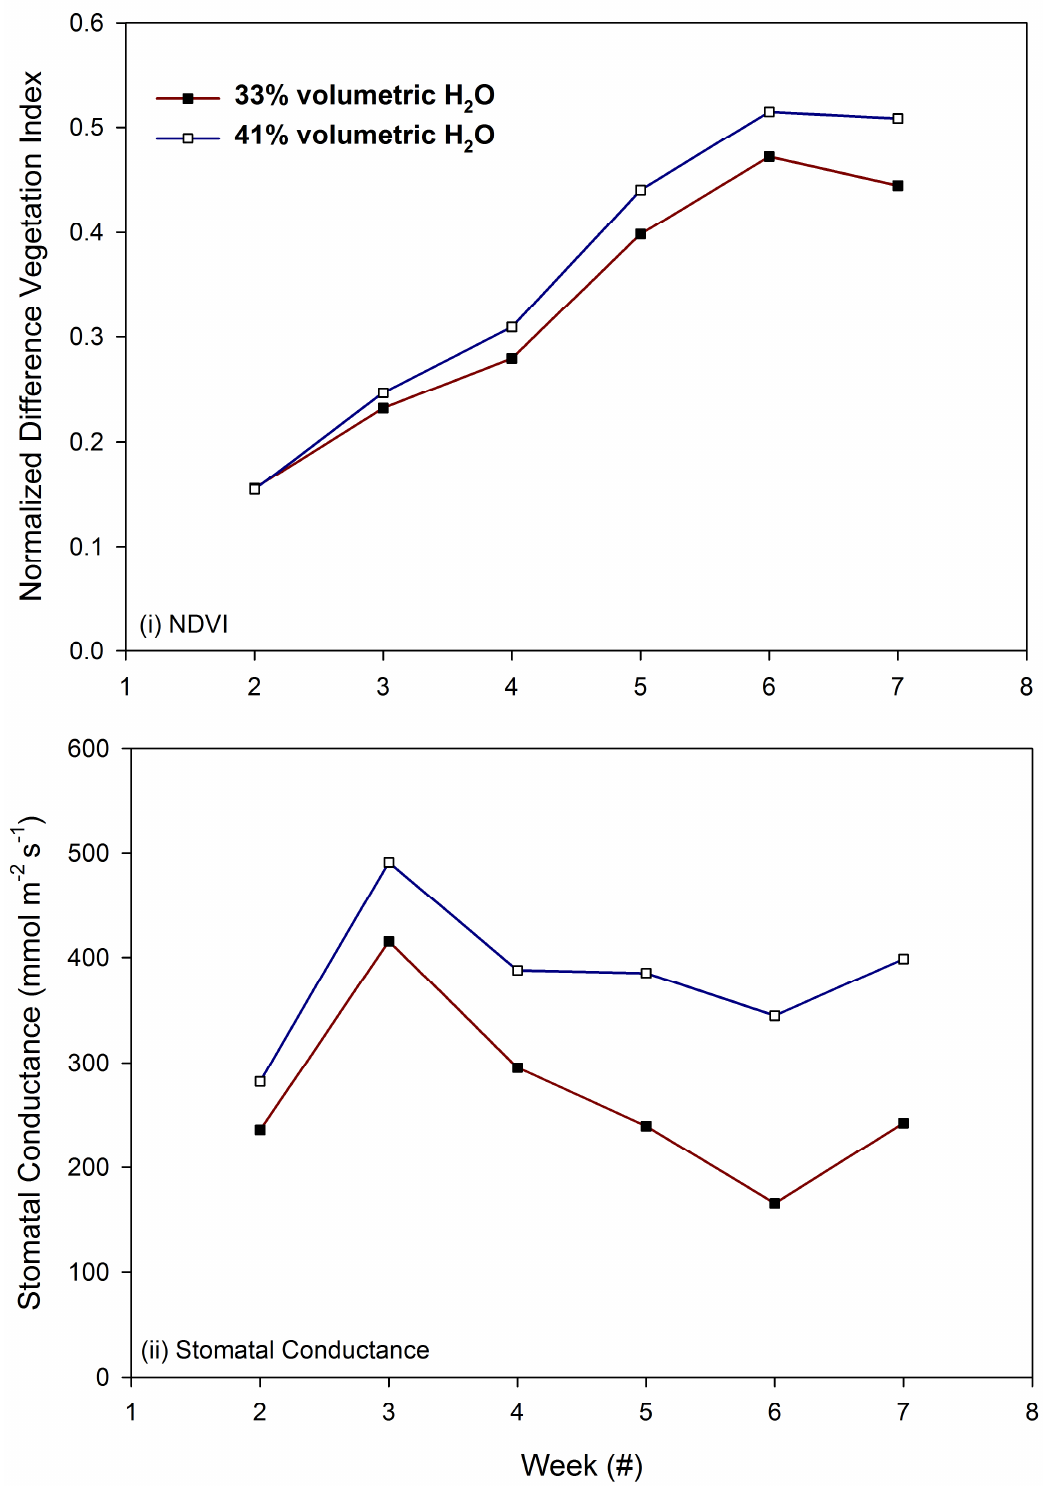
Figure 4. Temporal changes of ( i ) normalized difference vegetation index (NDVI) and ( ii ) stomatal conductance (g s ) per water content treatments. The changes on a weekly basis of the NDVI and stomatal conductance measurements for mean values of each treatment combination are shown. In both panels, the high water content (41% volumetric water content) is shown to represent the most productive results, while the lower water content (33% volumetric water content) displayed the